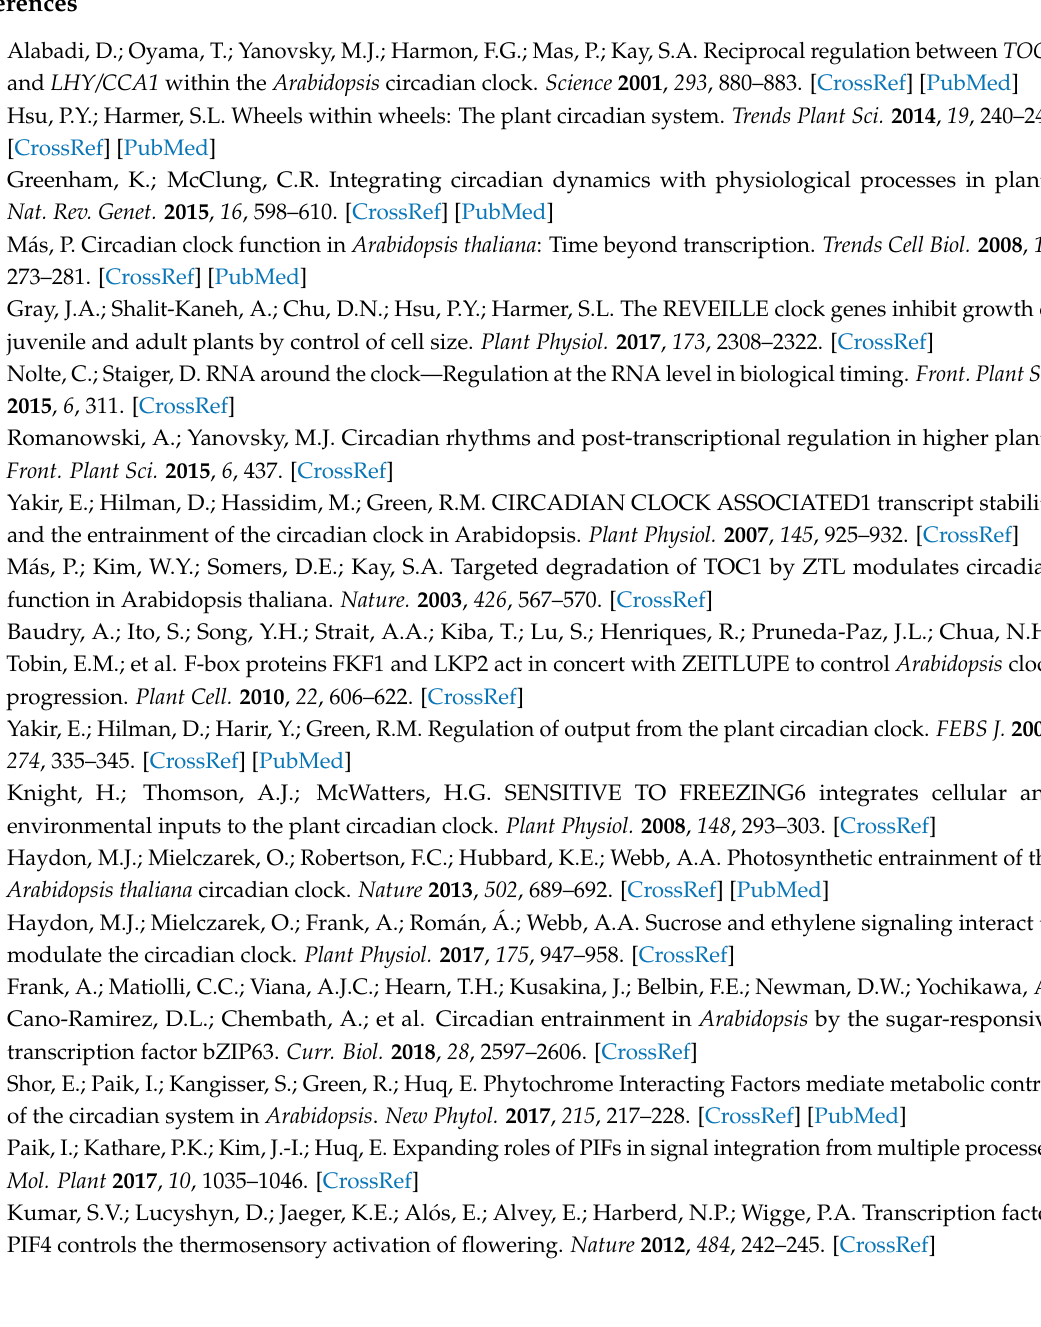
Figure S1: The effects of PIF -overexpression on levels of individual PIFs. Table S1: Primers, used for